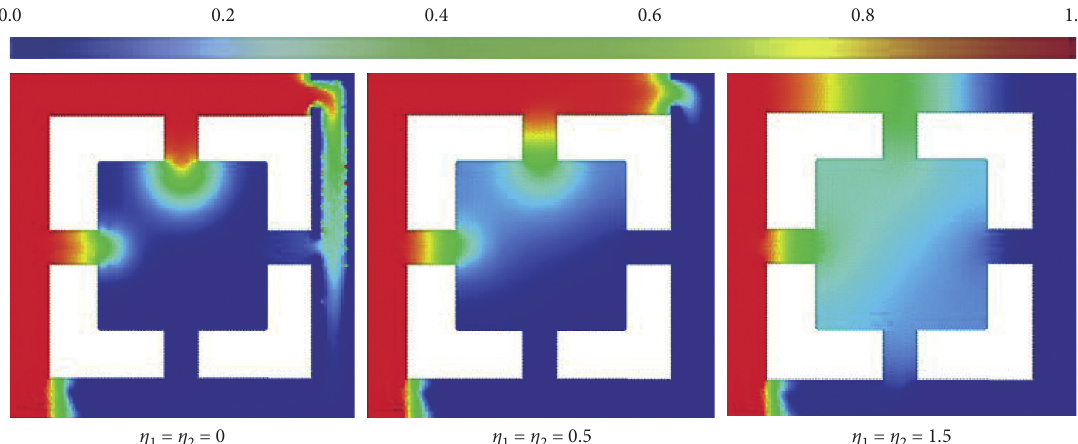
Figure 13: Features of concentration below the variations of a porous level, η Le � 20, and τ � 1.